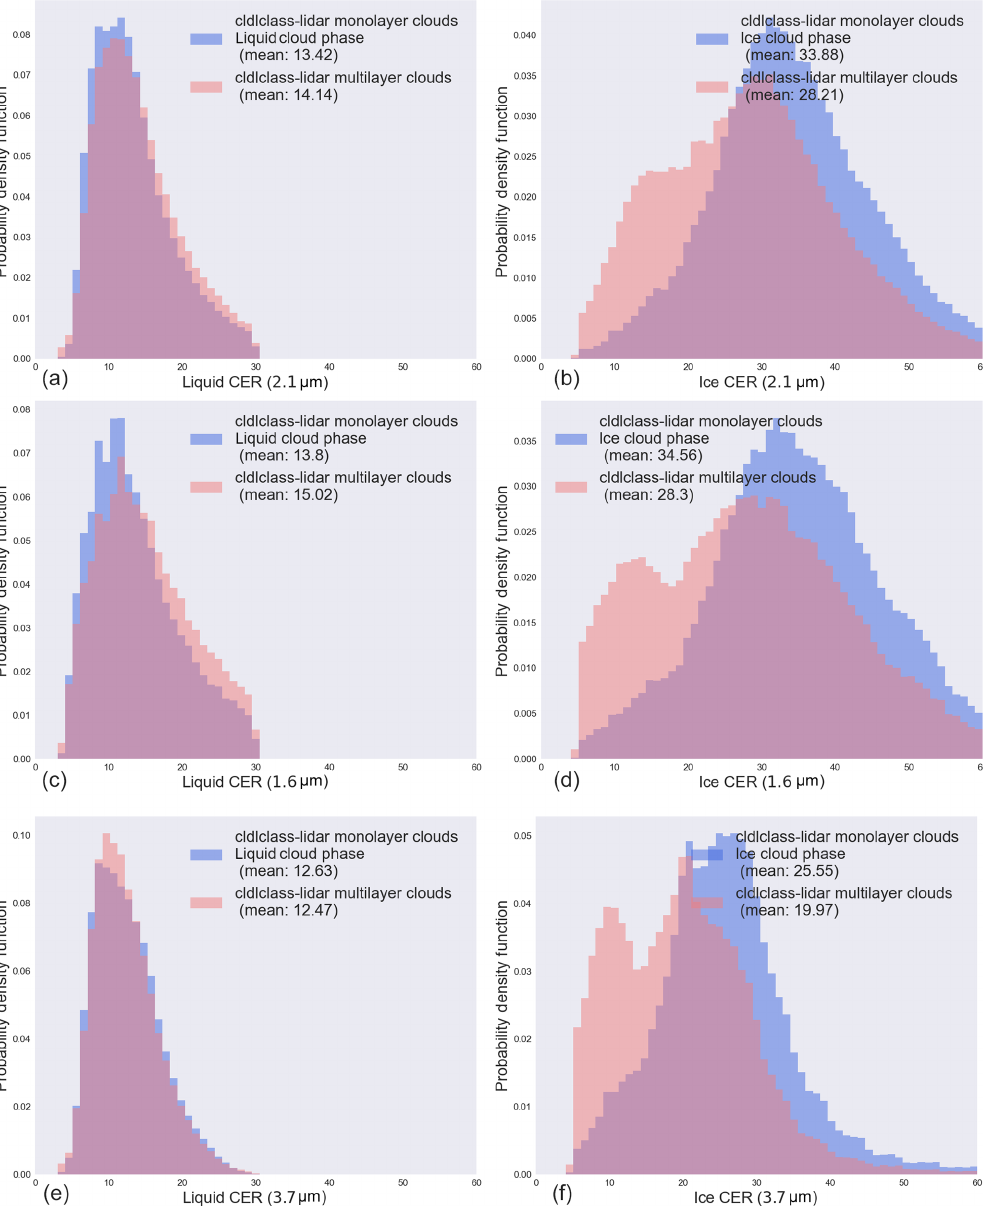
Figure 8. MYD06 1.6, 2.1, and 3.7µm liquid (a, c, e) and ice (b, d, e) CER retrieval distributions for monolayer (light blue) and multilayer (light red) cloud populations as determined by the 2B-CLDCLASS-lidar products regardless of the cloud layer separation distance or the upper-layer cloud optical